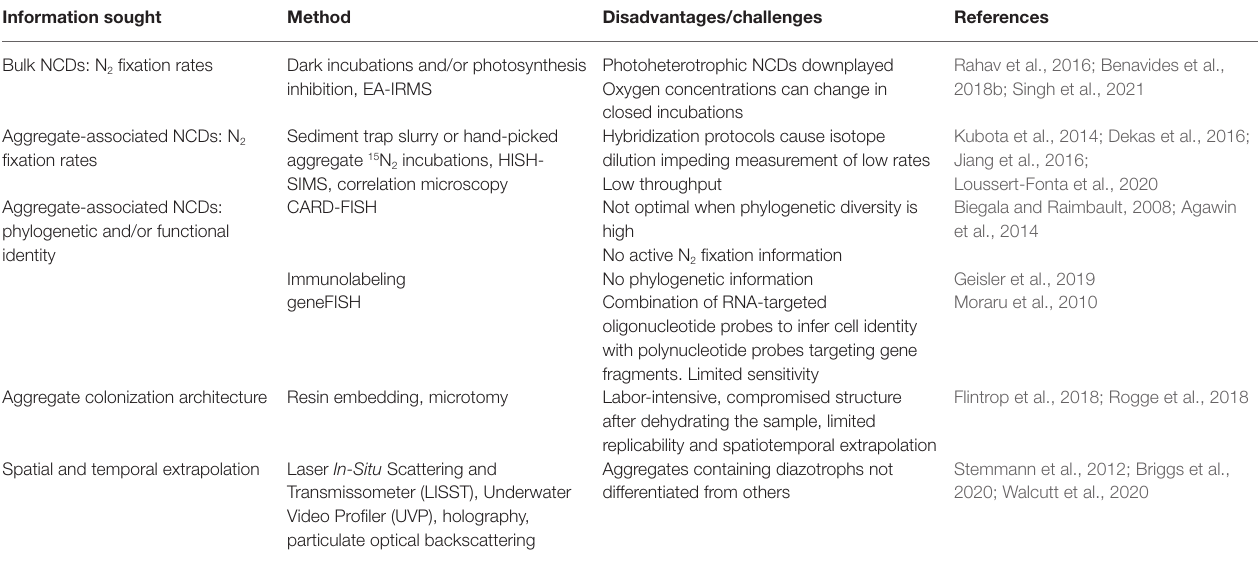
TABLE 1 | Proposed methods to study aggregate-associated